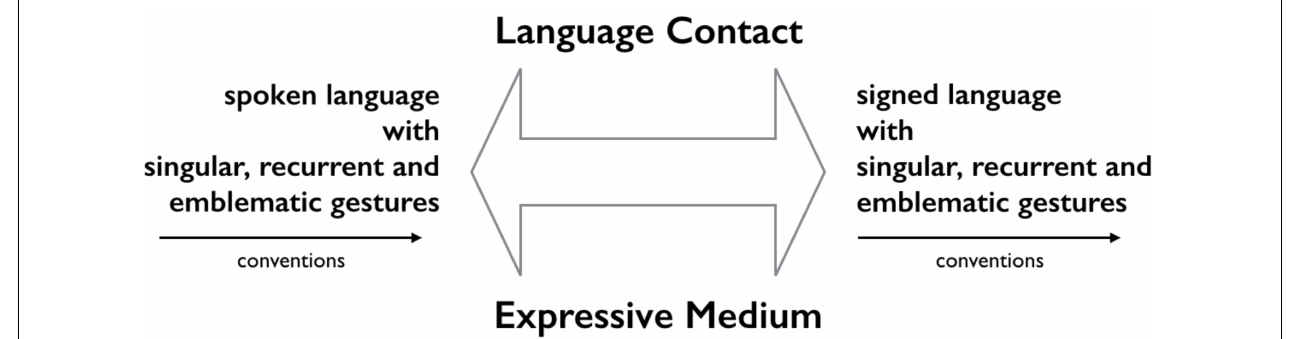
FIGURE 7 | Comparing multimodal languages: media commonalities and language contact.